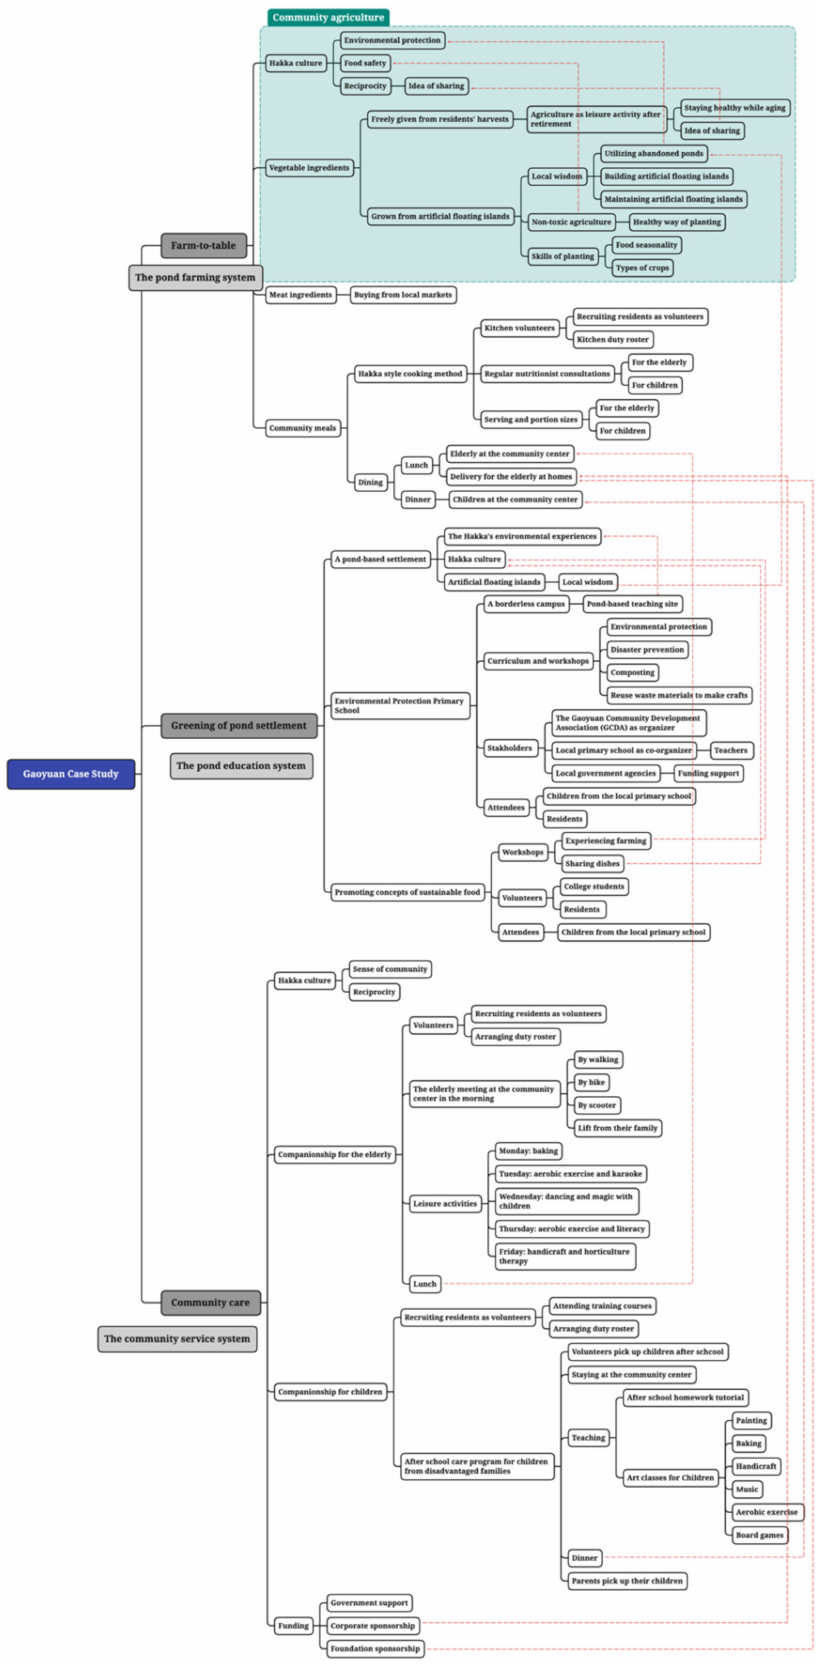
Figure 2. Thematic mapping of interview